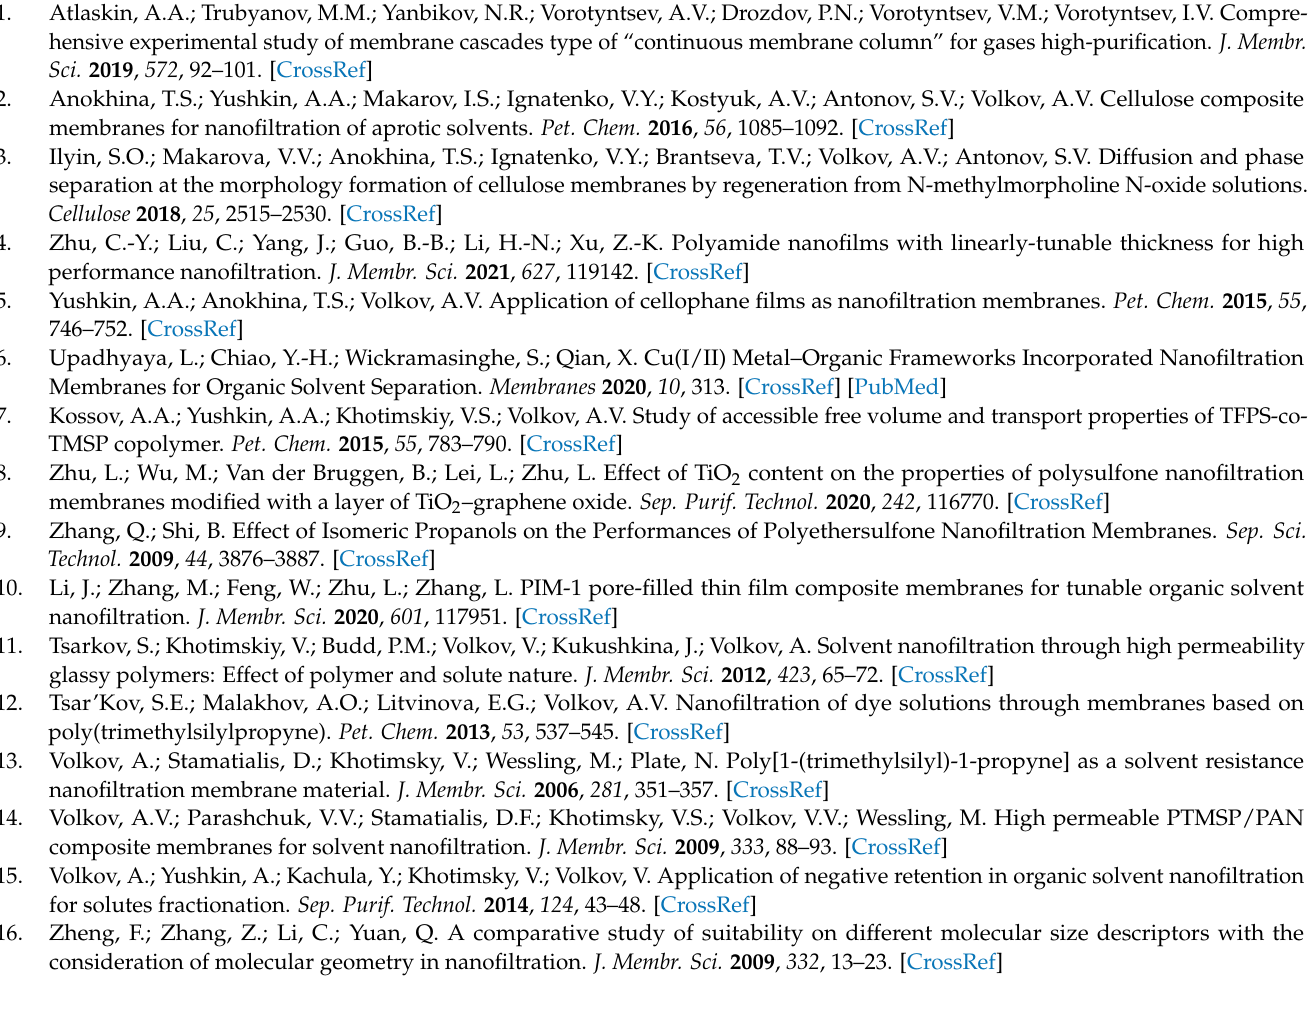
Figure S2: FTIR of PIM-1/UPM-20 membrane and powder of MIL-125 and MIL-140A; Figure S3: XRPD of (a) MIL-125 and (b)